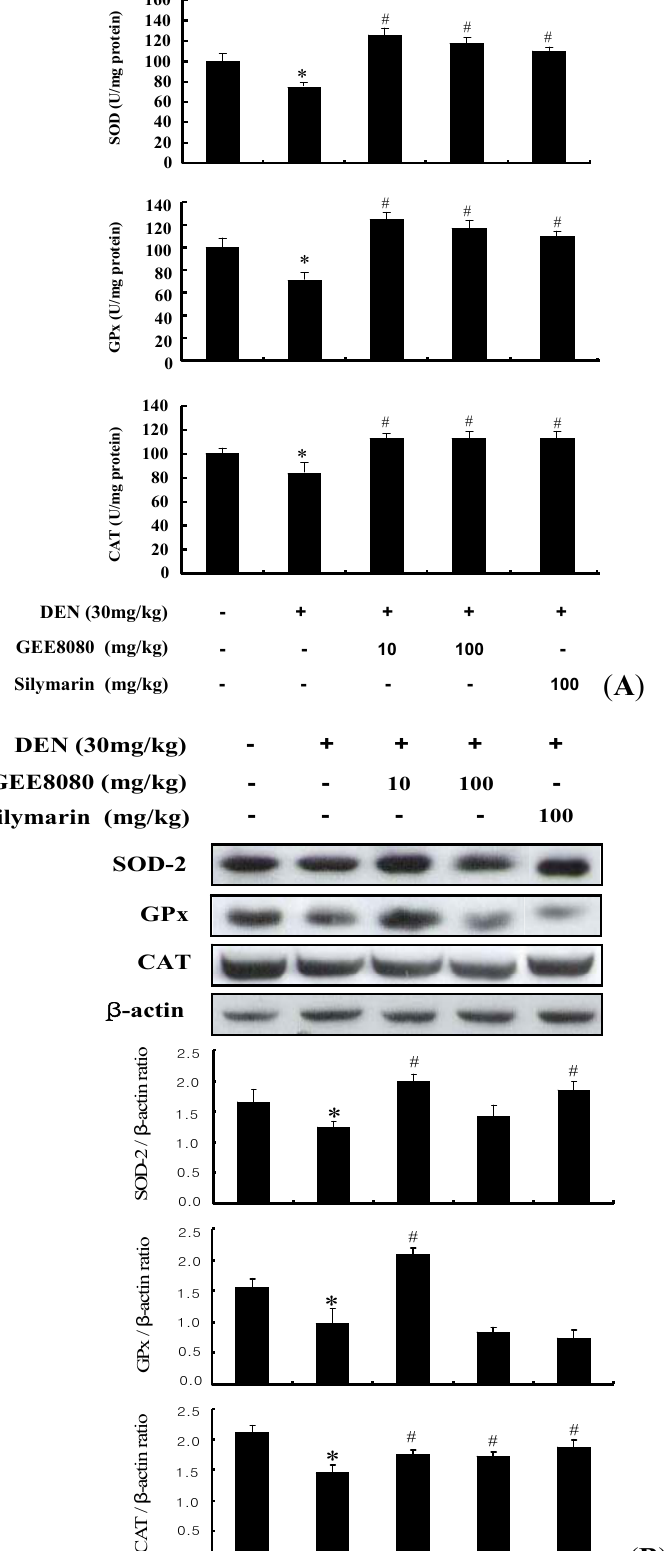
Figure 9. Effects of ginger extracts on ( A ) hepatic SOD, GPx and CAT activities and ( B ) protein expressions in DEN-induced mice. Each value represents the mean ± S.D. for 4 mice. * p < 0.05, significantly different from the unstimulated control group. # p < 0.05, significant differences from the DEN-treated